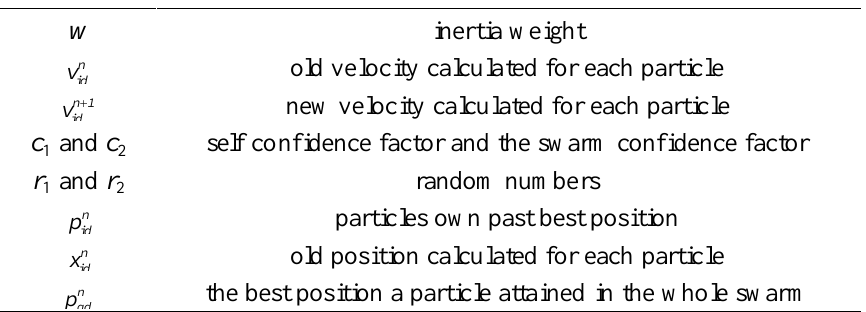
Table 1. Notations used in